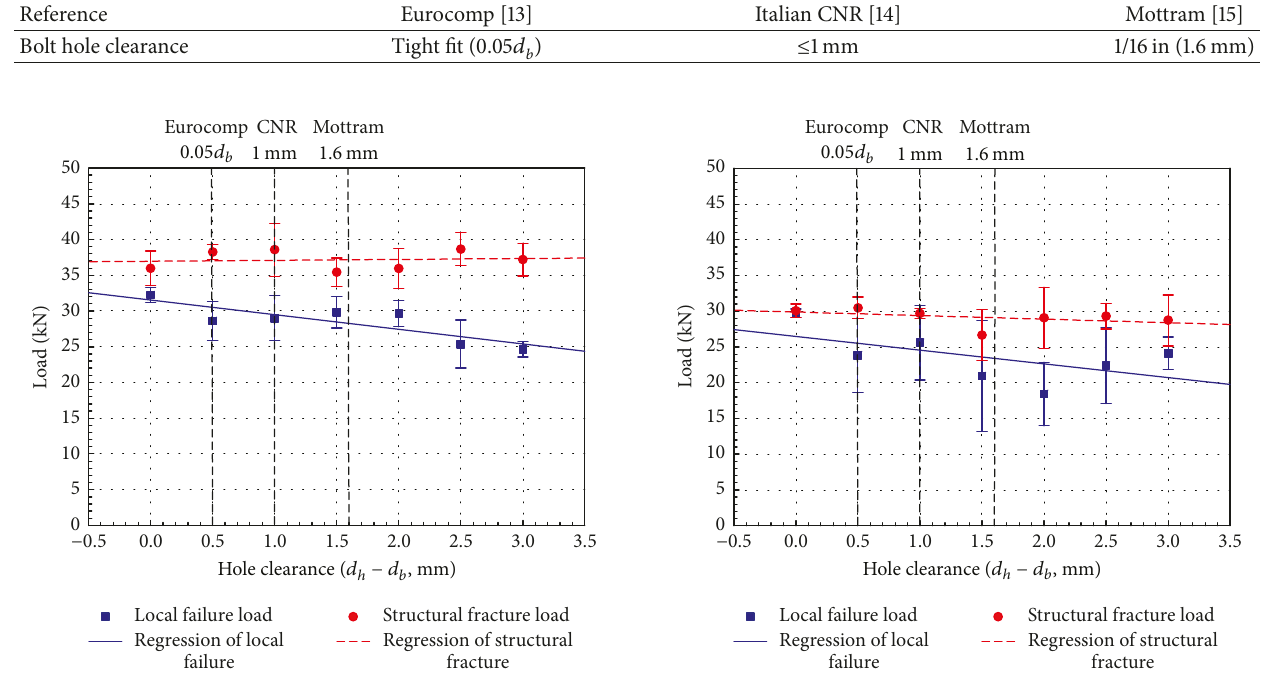
Figure 14: Relationship between load and bolt-hole clearance (specimen from I-shape-2).